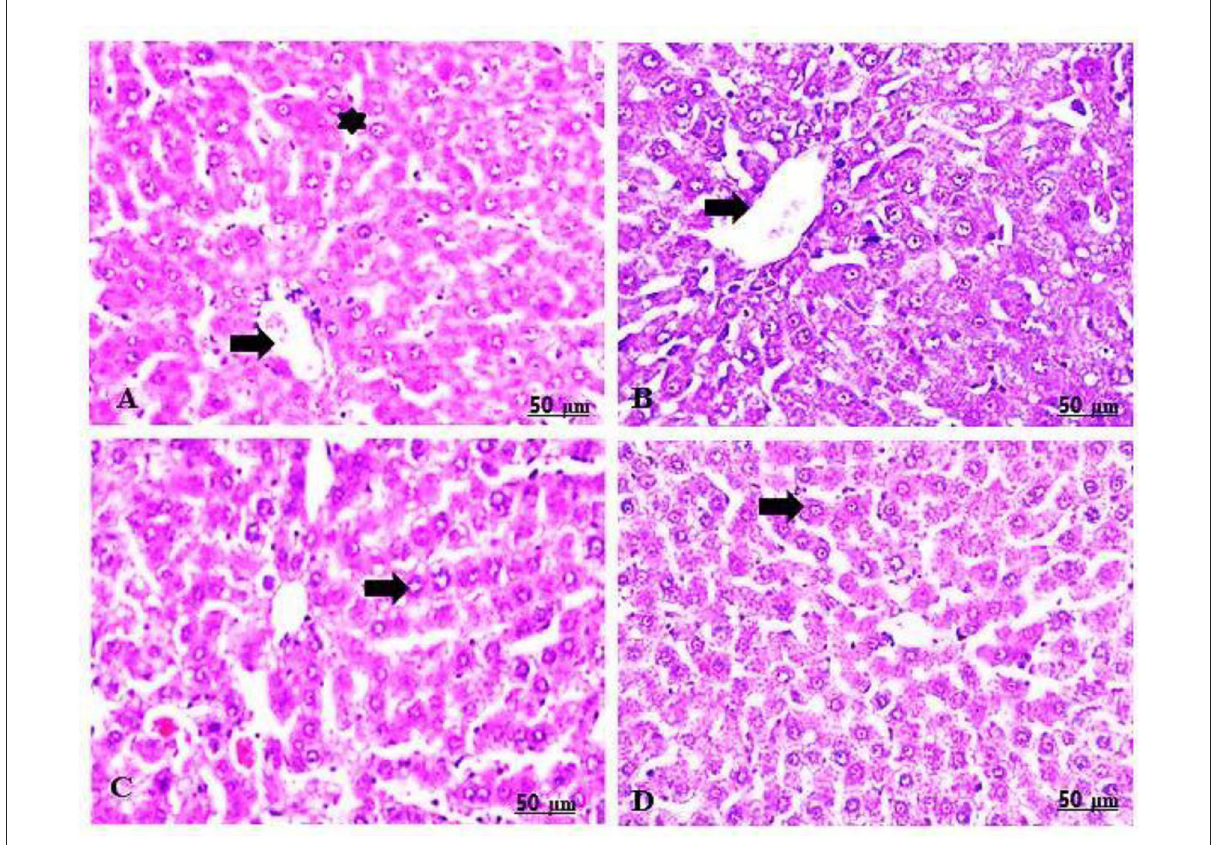
FIGURE8 (A–D) Light photomicrograph of sections from the maternal liver of GTiO 2 NPs exposed groups. GTiO 2 NPs of 100 mg/kg bwt show slight congestion and dilatation of the central vein (arrow), in addition to the regeneration of some hepatocytes (star) (A,B) . GTiO 2 NPs of 300 mg/kg bwt showing regeneration of the hepatocytes in trial to restore normal histological structures (C,D)